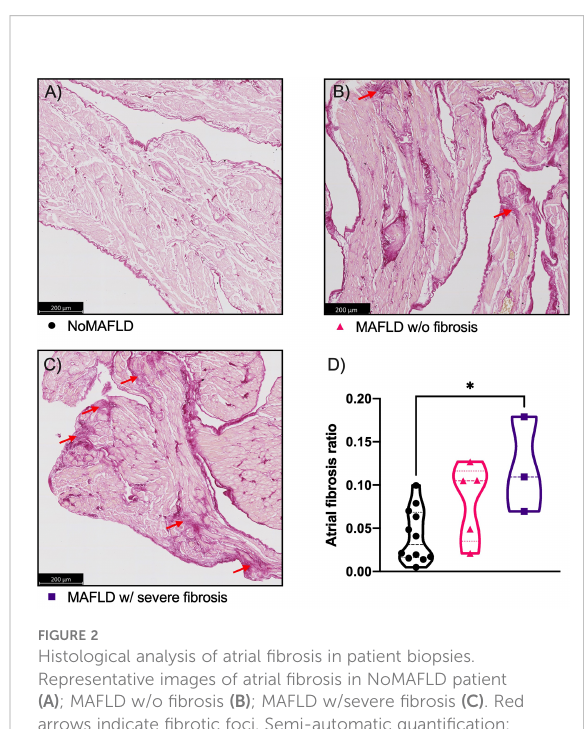
FIGURE 2 Histological analysis of atrial fi brosis in patient biopsies. Representative images of atrial fi brosis in NoMAFLD patient (A) ; MAFLD w/o fi brosis (B) ; MAFLD w/severe fi brosis (C) . Red arrows indicate fi brotic foci. Semi-automatic quanti fi cation: ratio between positive fi brotic area and total selected area (D) . NoMAFLD: FLI < 60; MAFLD w/o fi brosis: FLI > 60 and NFS < 1.455; MAFLD w/severe fi brosis: FLI > 60 and NFS > 0.675. Kruskal – Wallis test followed by Dunn ’ s post-hoc test. *p < 0.05. MAFLD, metabolic dysfunction-associated fatty liver